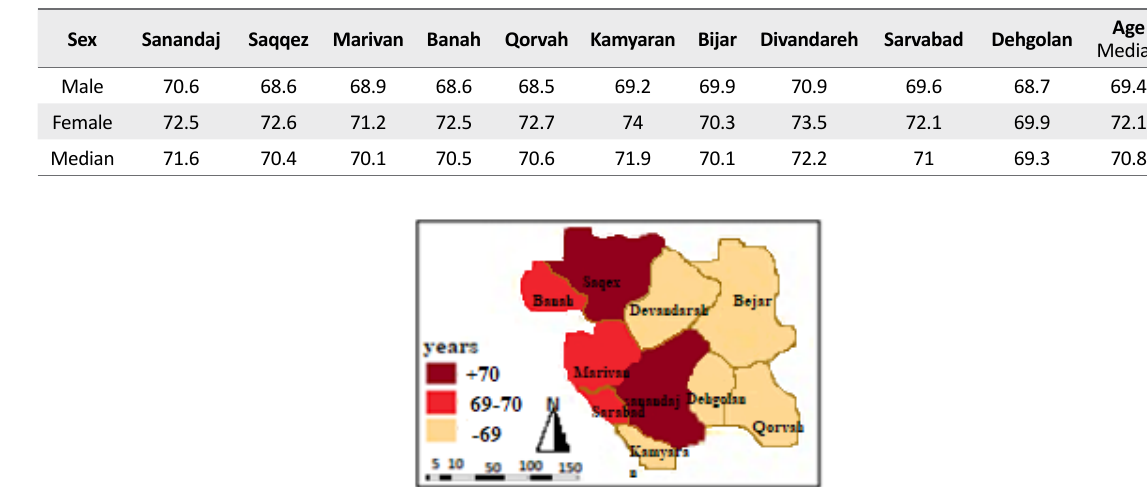
Table 3. Comparison of average life expectancy at birth for men and women in rural areas of Kurdistan Province, 2013